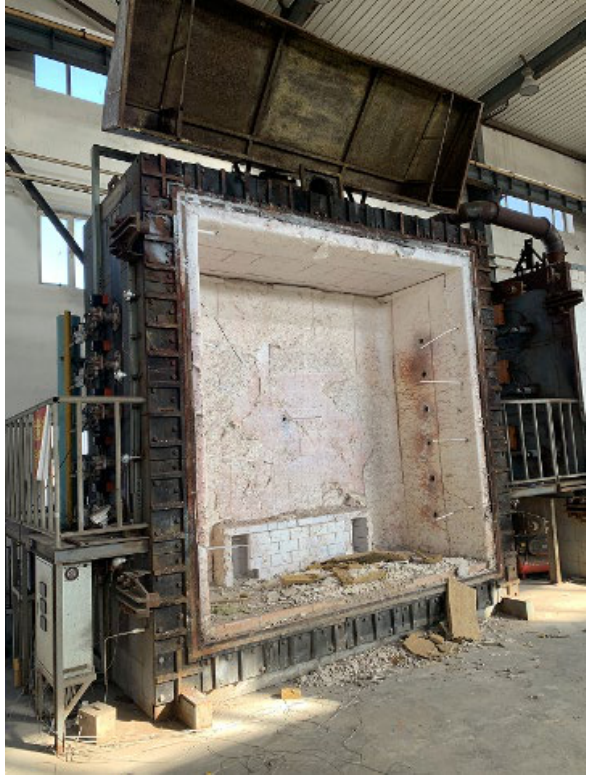
Figure 6. Refractory test furnace.